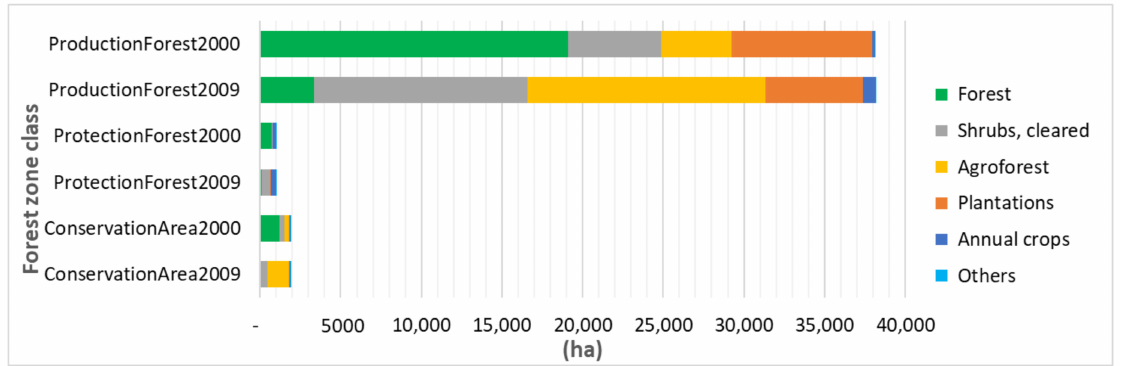
Figure 6. Land cover trajectories (2000 and 2009) of 2019 independent smallholder oil palm in each Forest-zone class in Jambi (based on